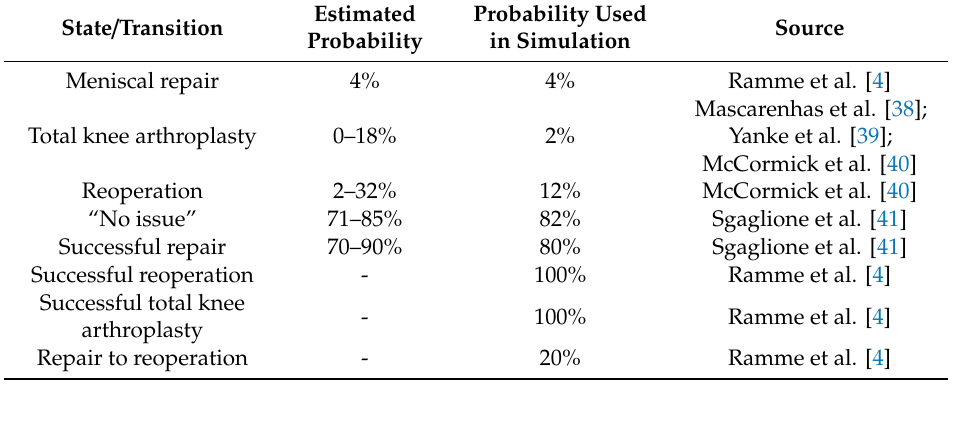
Table 2. List of state / transition probabilities in traditional meniscus transplantation.